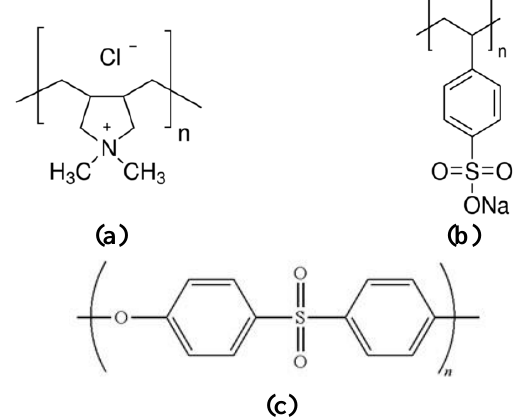
Fig 2. Molecular structures of materials used to synthesize PEM TFC membranes: (a) PDAC, (b) PSS, and (c)